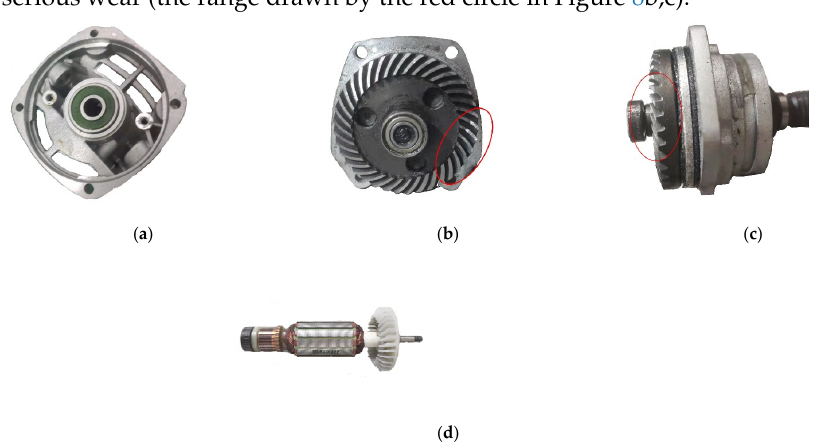
Figure 8. Disassembly results of angle grinder No. 2. ( a ) Bearing; ( b ) front view of bevel gear; ( c ) side view of bevel gear; ( d ) rotor.